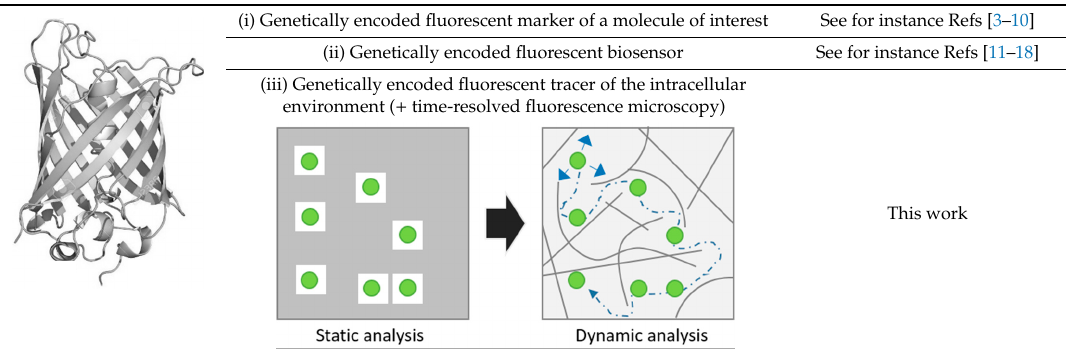
Table 1. Genetically encoded fluorescent proteins are mainly used for three major scopes: (i) as fluorescent markers of a molecule of interest, (ii) as biosensors, (iii) as inert tracers of the intracellular environment in conjugation with time-resolved microscopy. Time-resolved microscopy allows to move from a ‘static’ analysis of fluorescent proteins (FPs) localization in space only to a ‘dynamic’ analysis of FP localization both in space and time. This in turn may contain information on the intracellular environment where FPs are di ff using and